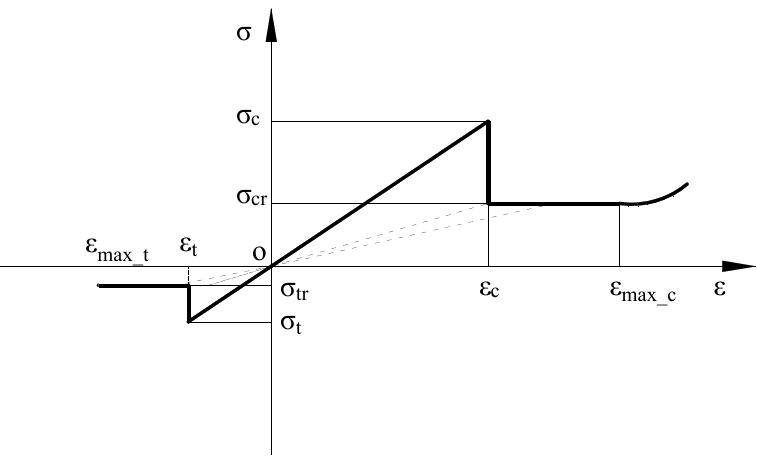
Figure 2. Elastic-brittle constitutive relation of an element under uniaxial stress state.